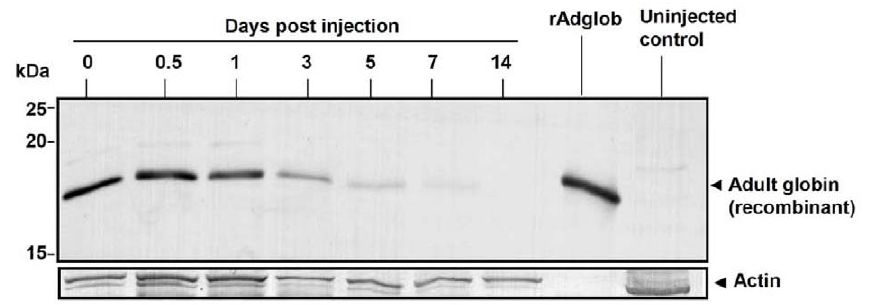
Figure 2. Time course detection of rHb within tadpoles after injection. Western blot using rabbit antibody to adult globin to detect persistence of rHb emulsion. n=3 animals pooled per time point. Actin indicates loading per protein sample (mAb mouse anti-actin used at